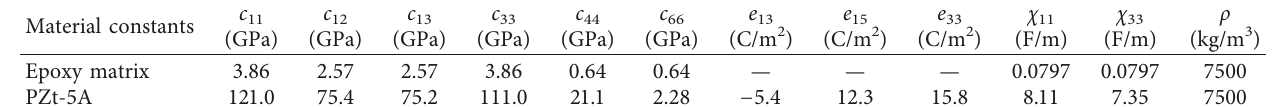
Table 1: Material constants for constituents of the PZT-5A and epoxy matrix.